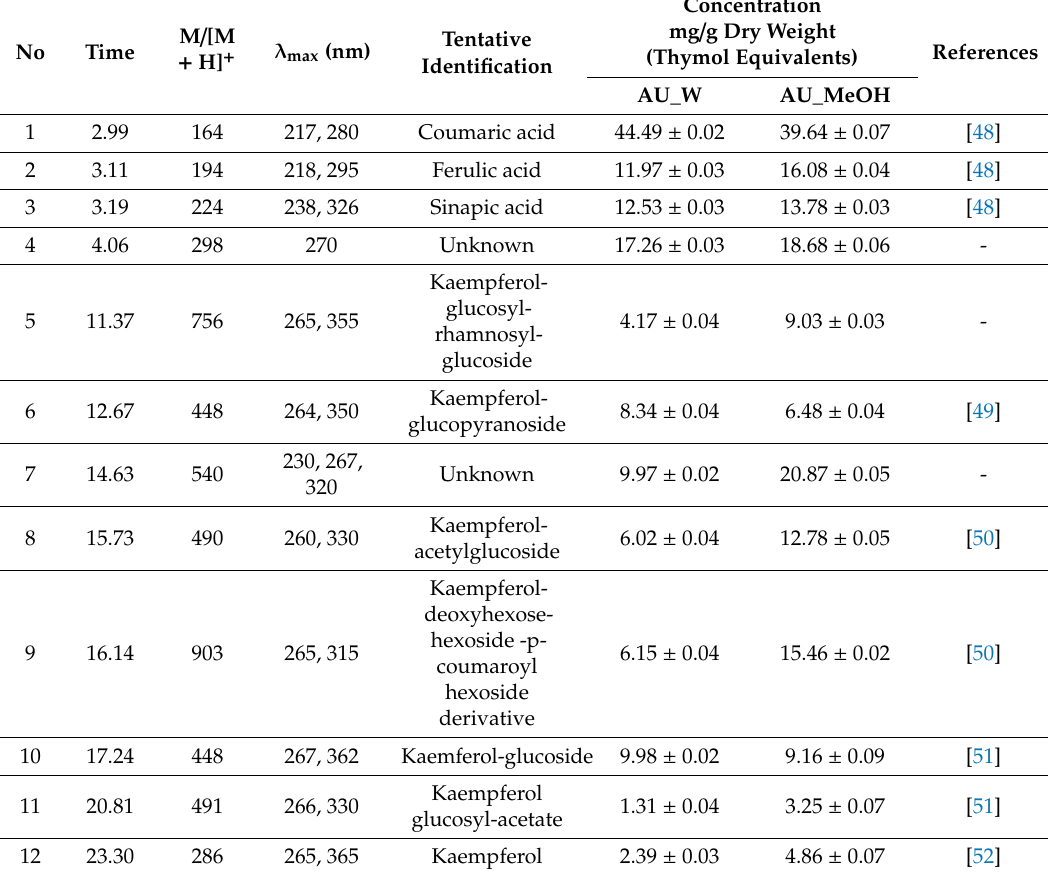
Table 3. Tentative identification, characterization and concentration of major compounds identified in Allium ursinum water and methanolic